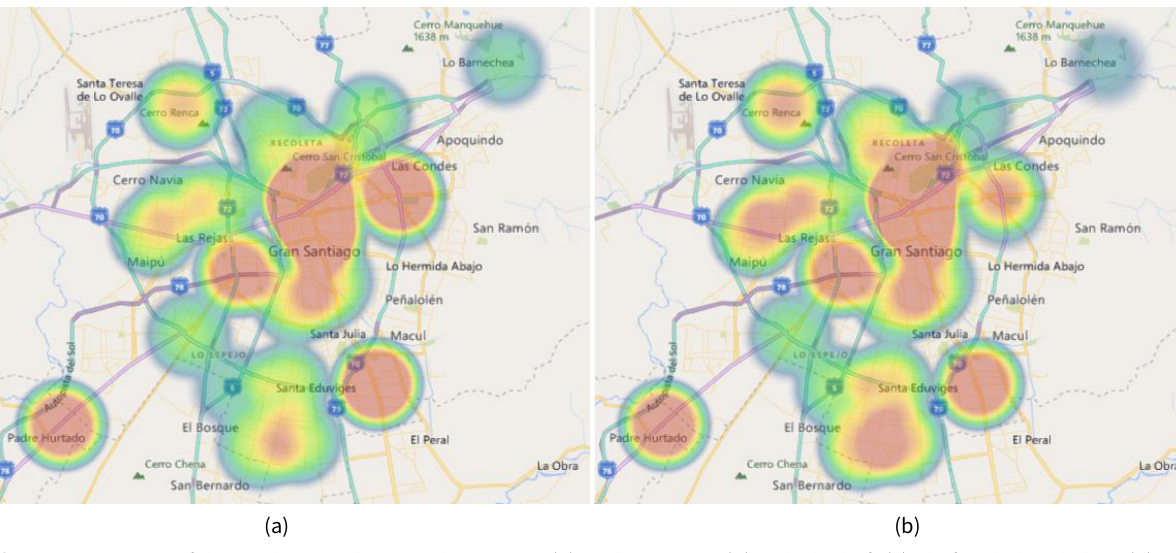
Figure 7. Heatmap of the total criminal events distribution (a), violent crimes (b), vehicle theft (c), theft in habited place (d) and crimes resulting in fatality